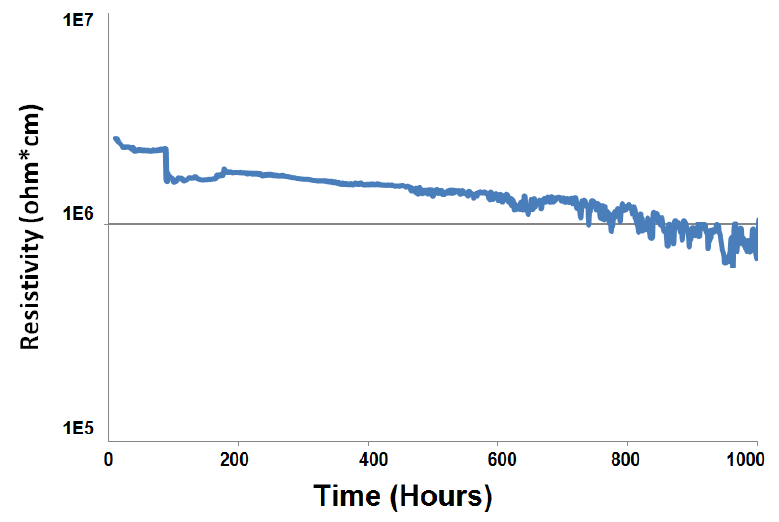
Figure 4. Electrical resistivity of the Crofer22APU/HJ14 glass-ceramic/Crofer22APU joined sampled, measured after 1000 h at 850 °C in a dual atmosphere .